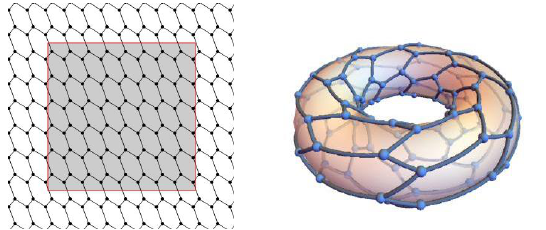
Figure 14. The drawing for ( m , n ) = ( 8,6 )